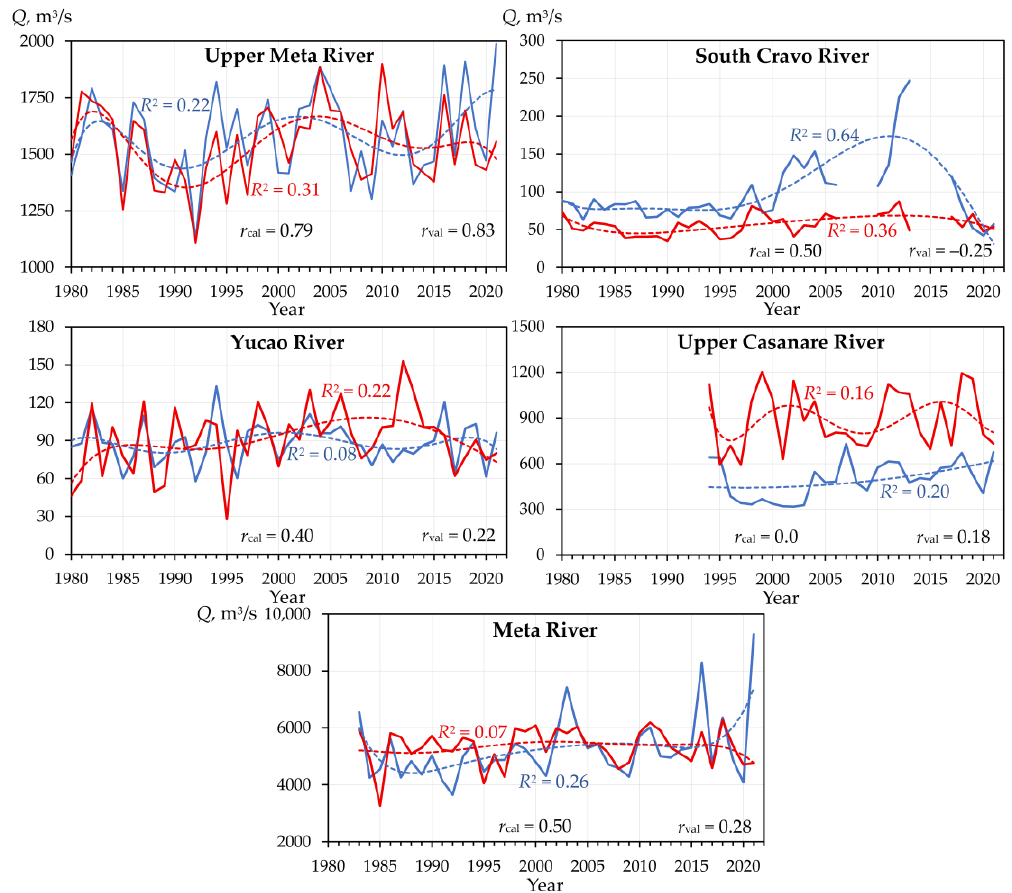
Figure 5. Changes in the observed (solid blue line) and modeled (solid red line) water discharge ( Q ) of the studied rivers of the Meta River basin for 1980 – 2021. The dotted line is the sixth-degree polynomial trend of the corresponding (observed or modeled) water discharge. R 2 is the coefficient of approximation of the trend line; r cal and r val are the correlation coefficients for the period of calibration (1983 – 2012) and validation (2013 – 2021), respectively.